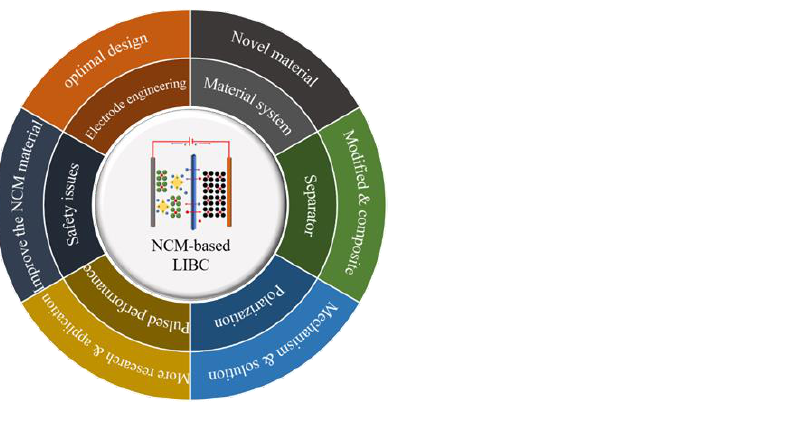
Figure 18. Schematic illustration of the research and development direction of NCM-based LIBC.